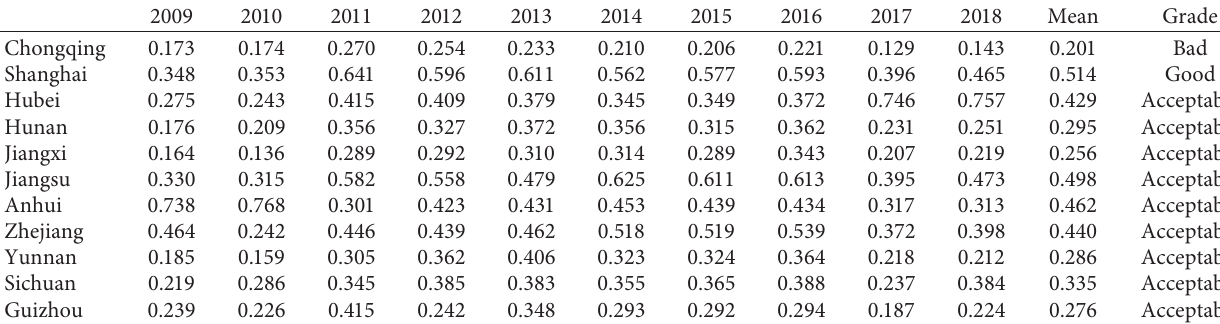
Table 4: DD of water governance subsystem.